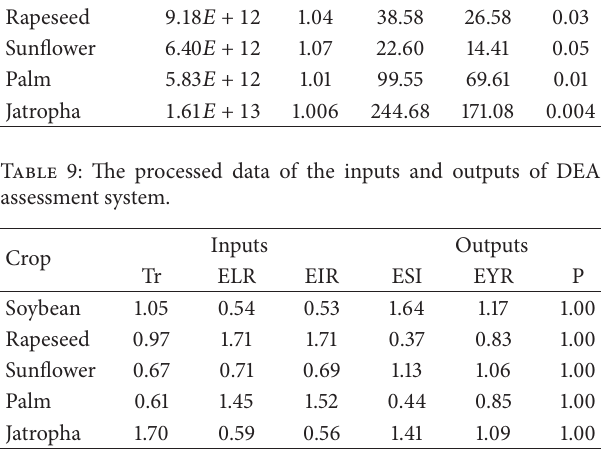
Table 8: Emergy indices of various crops-based biodiesel. Emergy indices Tr (sej/kg)